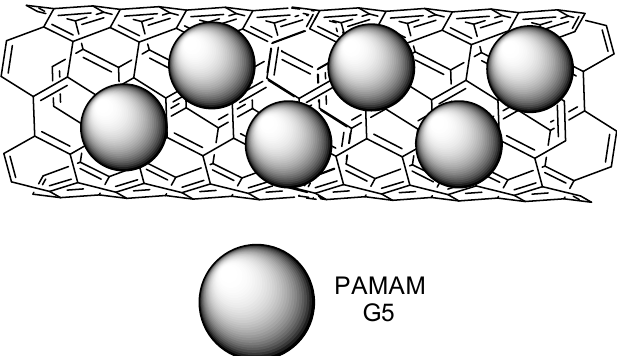
Figure 9. Schematic representation of the proposed binding mode of PAMAM on carbon nanotubes (CNT) [83].